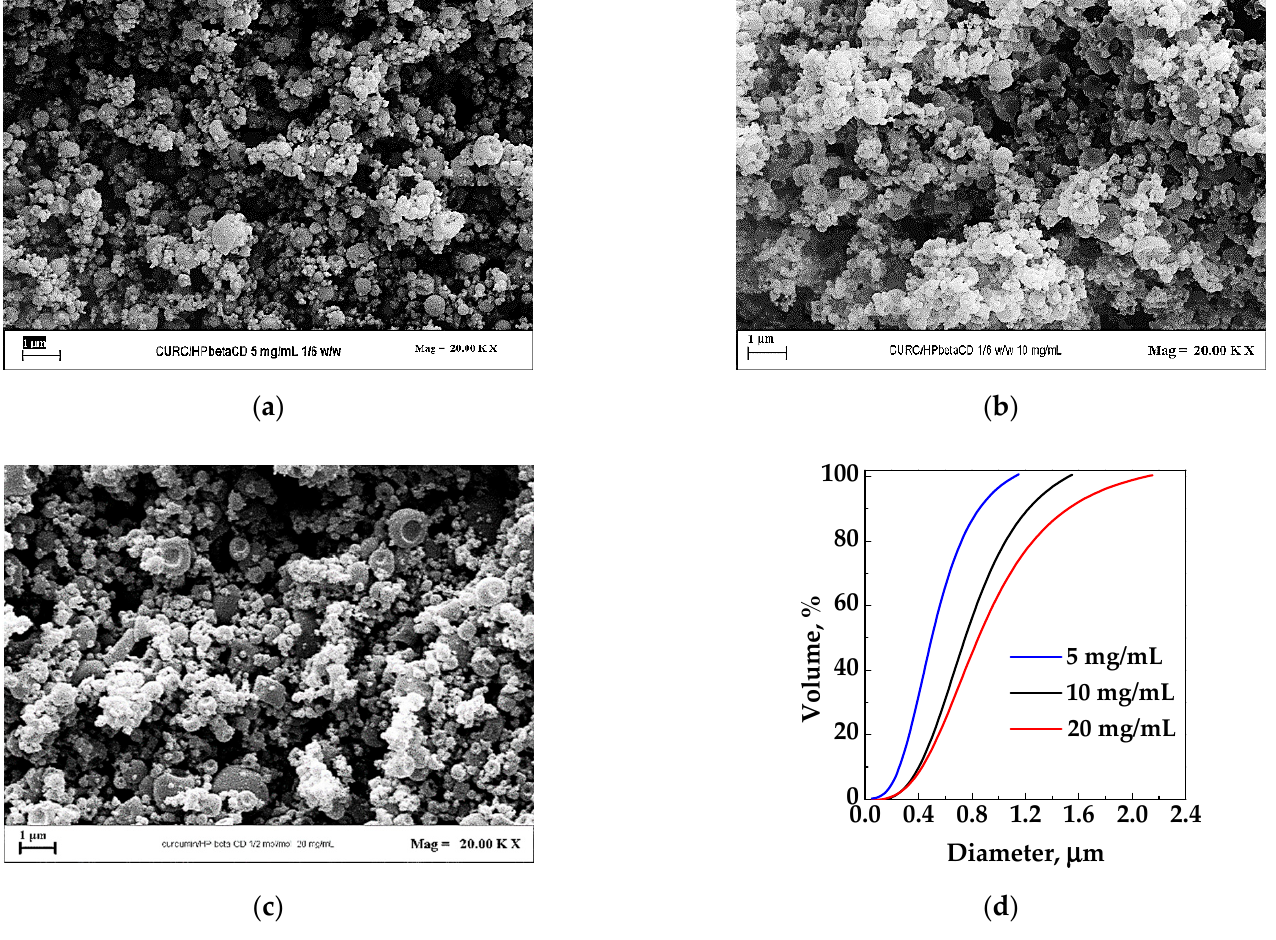
Figure 4. HP- β -CD/CUR particles produced by SAA from EtOH/H 2 O 70/30 at 6/1 w / w ratio. Effect of total concentration in the liquid solution: ( a ) 5 mg/mL; ( b ) 10 mg/mL; ( c ) 20 mg/mL; ( d ) particle size distribution of the powders obtained in correspondence of the different concentrations.